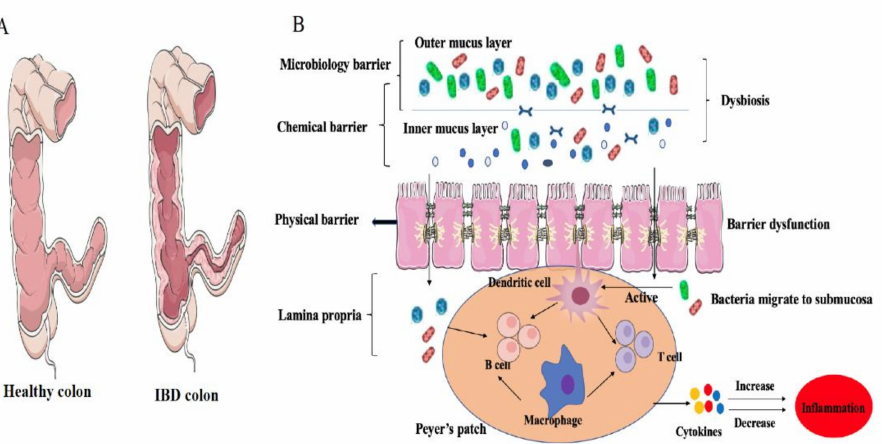
Figure 3. The physical state of the intestinal immune system in IBD hosts: ( A ) Comparison between the intestinal structures of a healthy colon and a colon with Crohn’s disease; ( B ) In IBD, a cascade inflammatory reaction happened, including colonic dysbiosis, enteric epithelial barrier dysfunction, active immunocyte, increased levels of